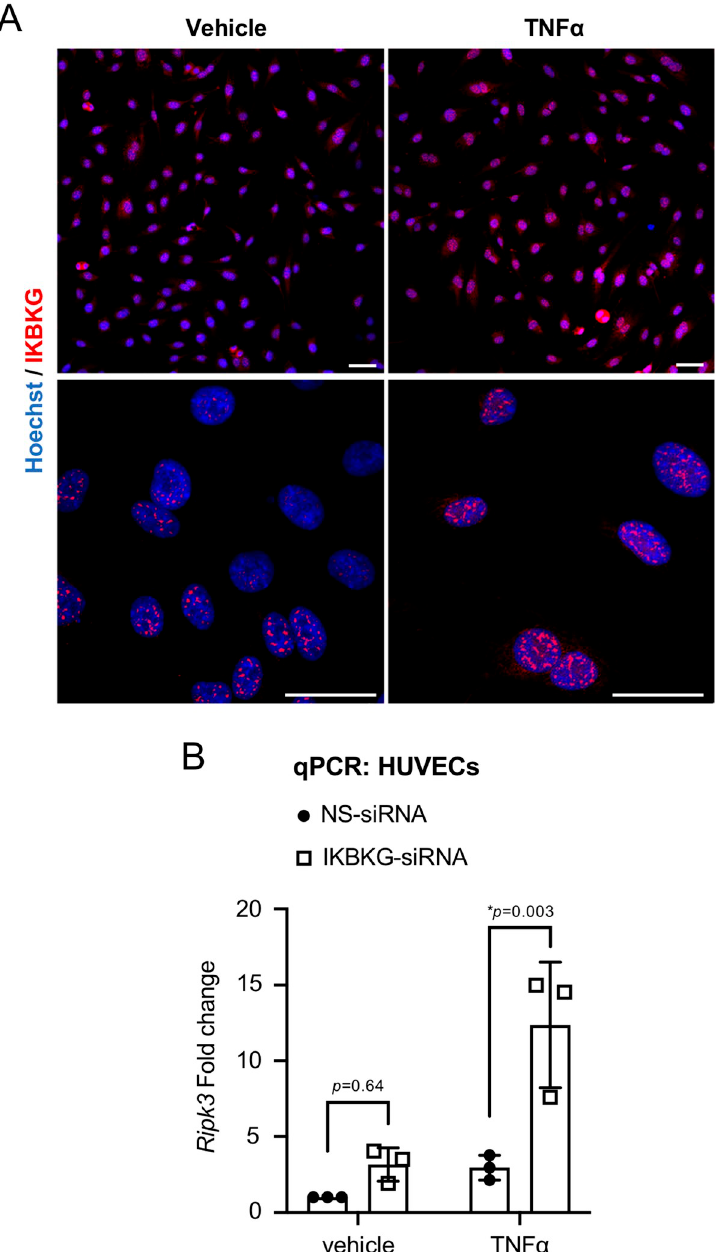
Fig 3. IKBKG is primarily localized in the nuclei of HUVECs and suppresses Ripk3 transcription after TNF α treatment. (A) HUVECs were treated with vehicle or TNF α (100 ng/mL) for 24 hr and subsequently immunostained for IKBKG (red). Cellular nuclei were counterstained with Hoechst (20 μ g/mL; blue). Representative images of single confocal optical sections are shown. Scale bars: 50 μ m. (B) HUVECs were transfected with nonspecific (NS) or IKBKG-specific siRNA oligos for 24 hr and were subsequently treated with vehicle (PBS) or TNF α (100 ng/mL) for 24 hr. Ripk3 transcripts were measured by qRT-PCR. Note that data generated from NS-siRNA-treated cells are identical to those shown in Fig 2A because the experiments were performed at the same time. Data from 3 independent experiments were combined and are presented as relative fold change. Data are presented as mean ± S.D. All statistics were calculated using a two-way ANOVA with a Tukey’s multiple comparisons test. ( � ) indicates statistical significance ( p < 0.05).